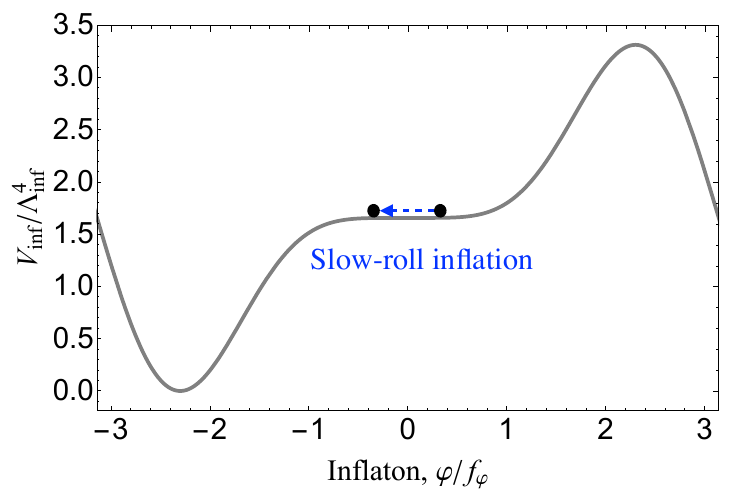
Figure 5 . Ultra low-scale inflaton potential, satisfying the TCC. Inflation takes place at ϕ ≈ 0 . The direction of slow-roll is shown by the blue dashed